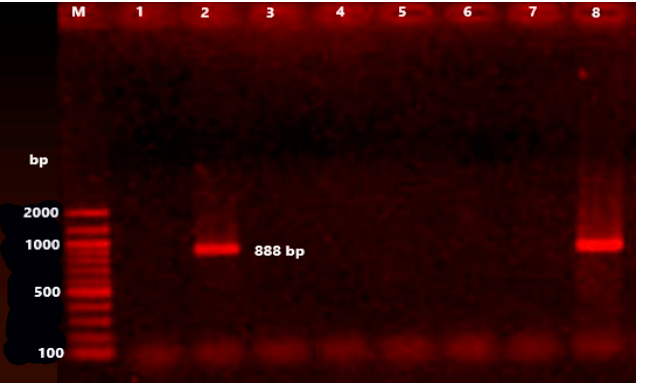
Figure 3. Electrophoresis pattern on agarose gel (1.0%) caused by the amplicons for the flo R gene (888 bp). Lane M is a 100 bp ladder as a molecular size standard. Lanes 2, 8: positive isolates. Lanes 1, 3–7: negative isolates.